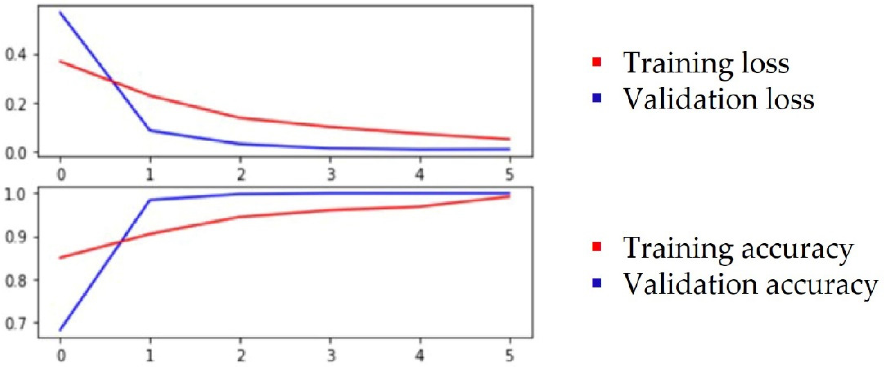
Figure 5. Plot of the training and validation loss and accuracy for ResNet50.